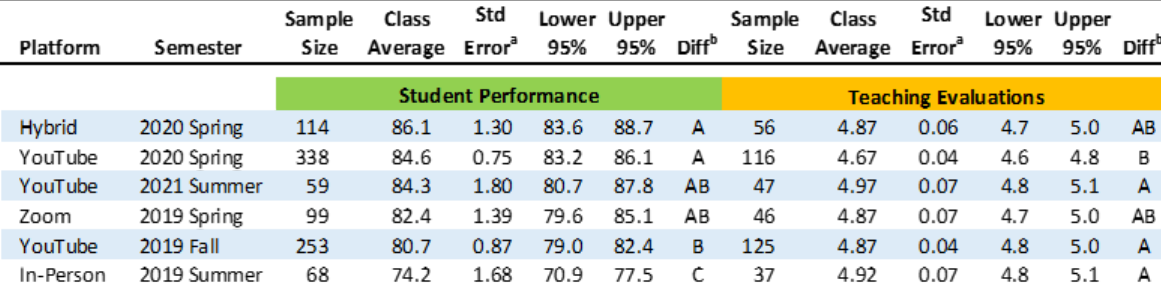
Table 1. Comparison of Stat 201 student performance and teaching evaluations across different teaching platforms—in-person, online via Zoom and YouTube, and hybrid—from 2019 to